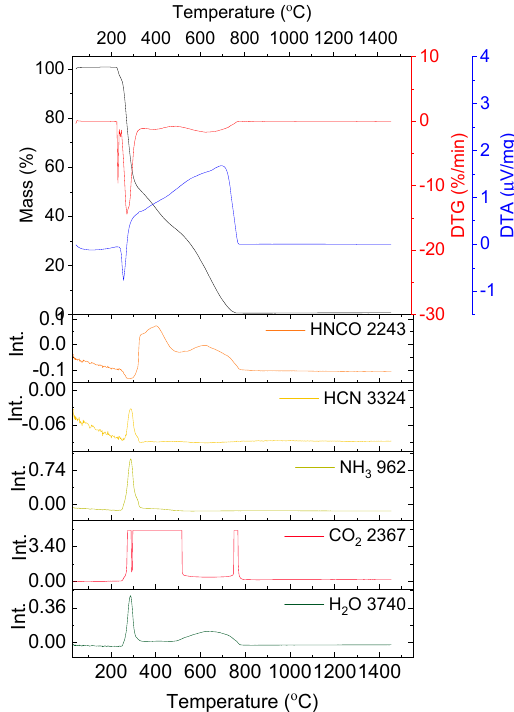
Figure 2. Thermal analysis results of the decomposition of glycine in synthetic air; absorbance intensities of traces for wavenumbers: 2243, 3324, 962, 2367 and 3740 cm − 1 corresponding with absorbance peaks of HCNO, HCN, NH 3 , CO 2 and H 2 O, respectively.